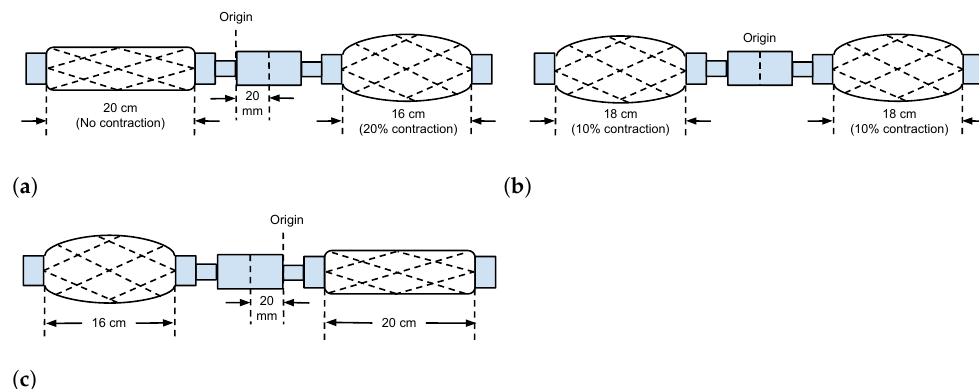
Figure 2. Illustration of antagonistic translational TMM servoactuator setup for 40 mm position control with no modification. The length of the setup has to be more than 36 cm. ( a ) Rightmost position; ( b ) center position; ( c ) leftmost position.